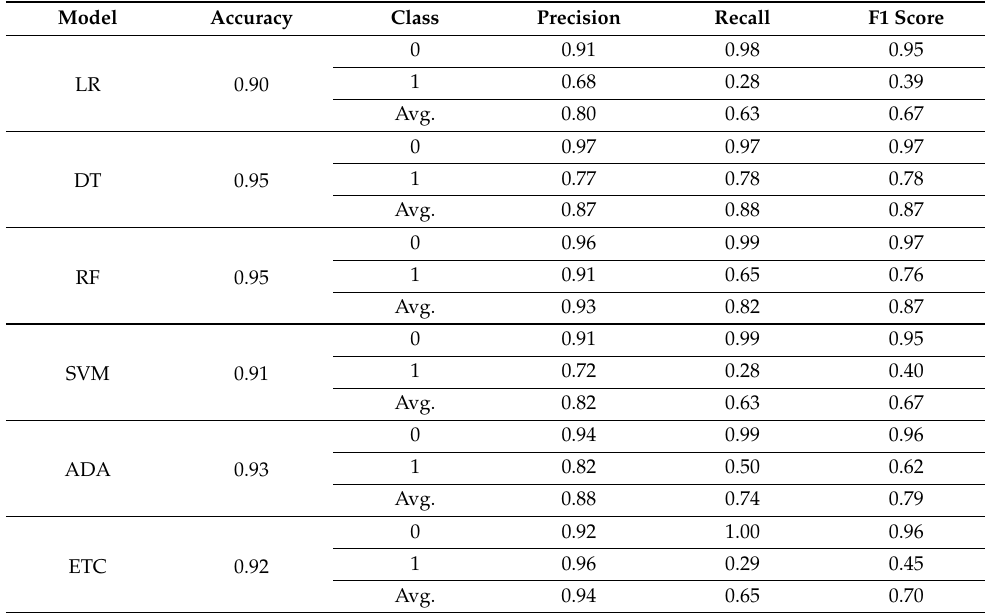
Table 7. Experimental results for the machine learning